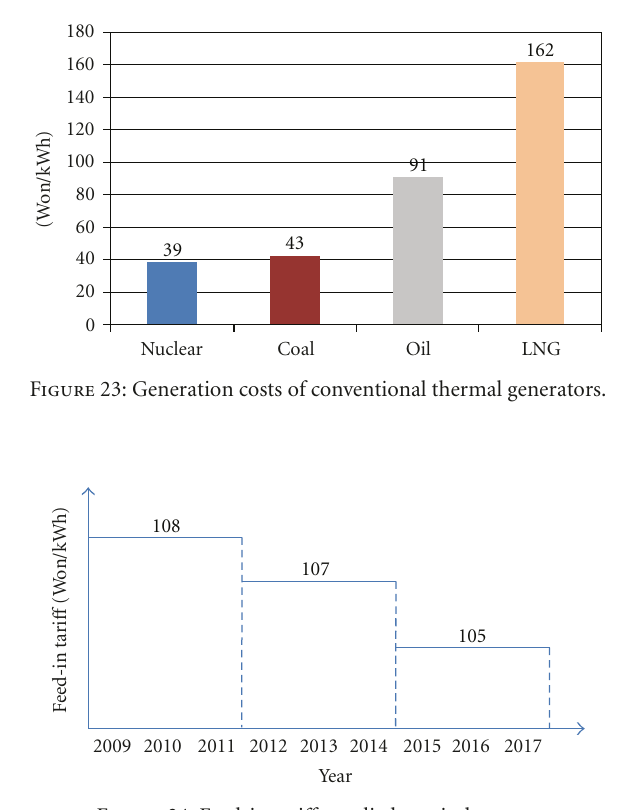
Figure 24: Feed-in tari ff s applied to wind energy.